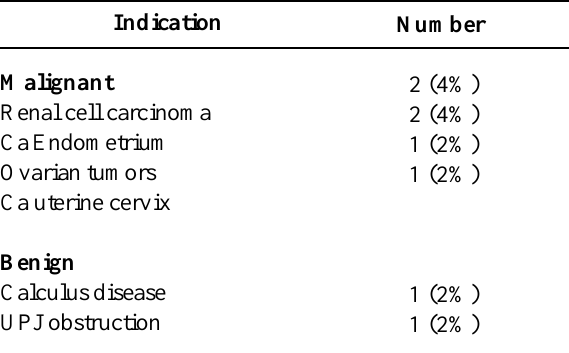
Table 4 – Comparison of serum creatinine (mg/dL) before and after percutaneous nephrostomy in all 50 cases.